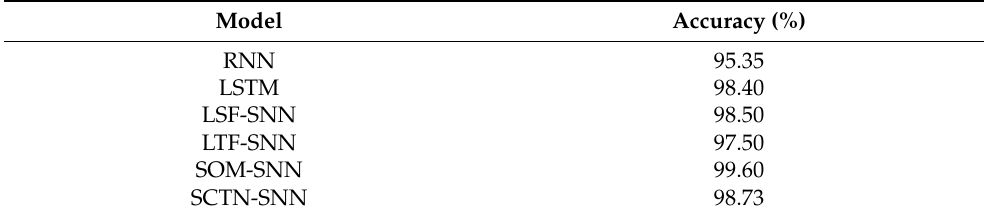
Table 1. Classification accuracy comparison (adapted and completed from the work in